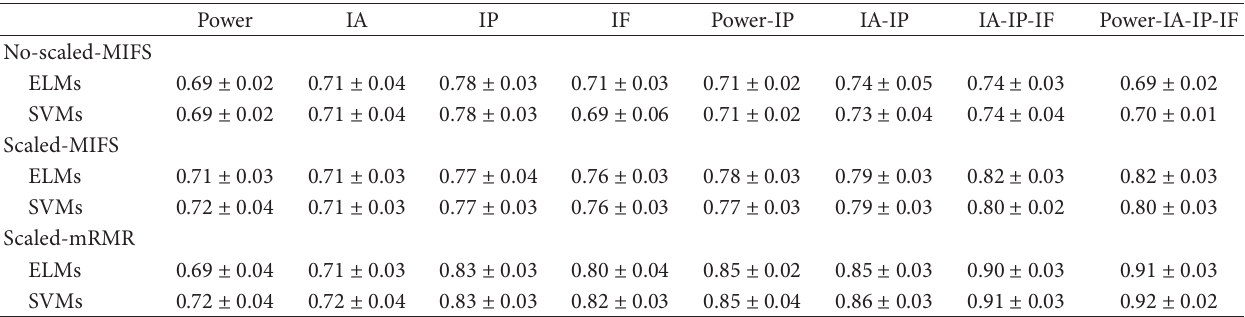
Table 1: The classification results using different feature processing methods and different feature types.